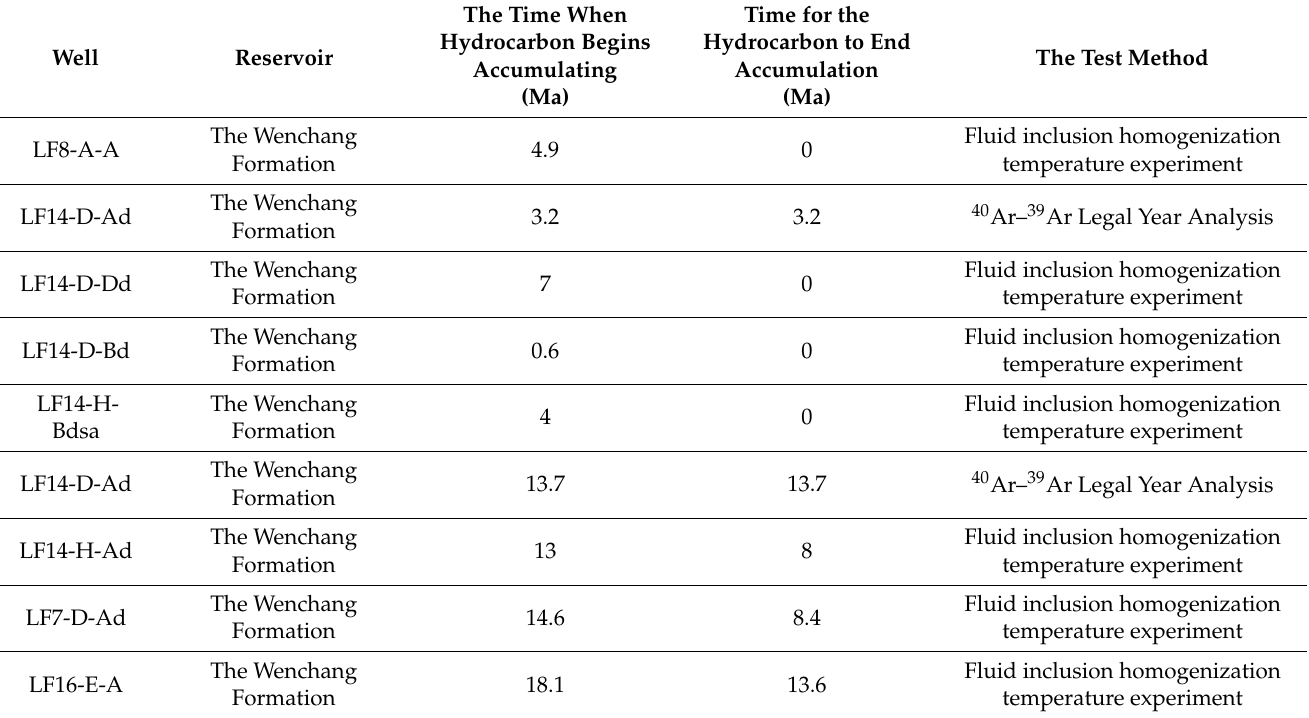
Table 1. Identification of hydrocarbon accumulation table based on reservoir fluid inclusions and Ar isotope dating.